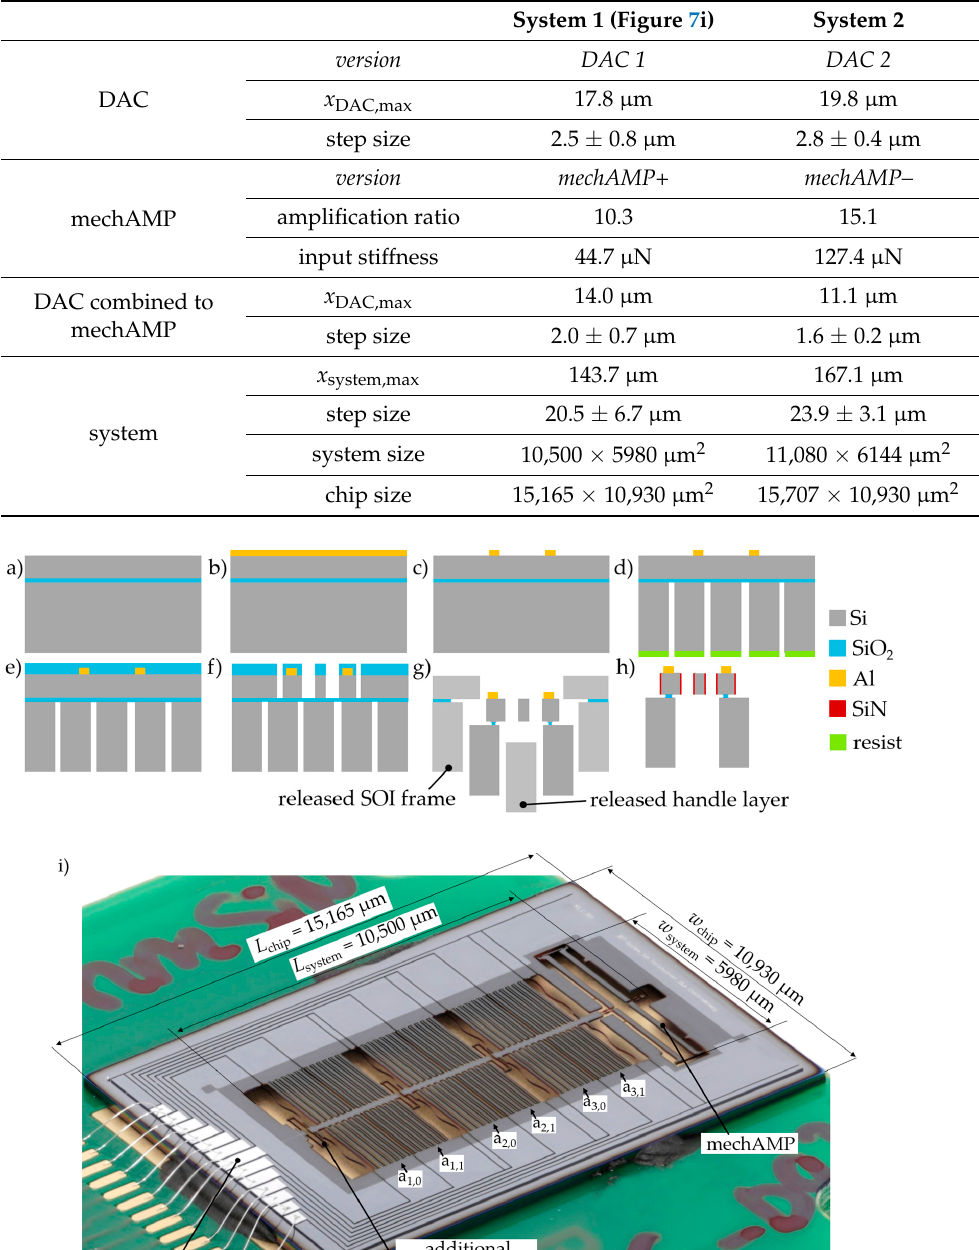
Table 2. Simulated DACs, mechAMPs and systems at a displacement of x electrode = 10 µ m.